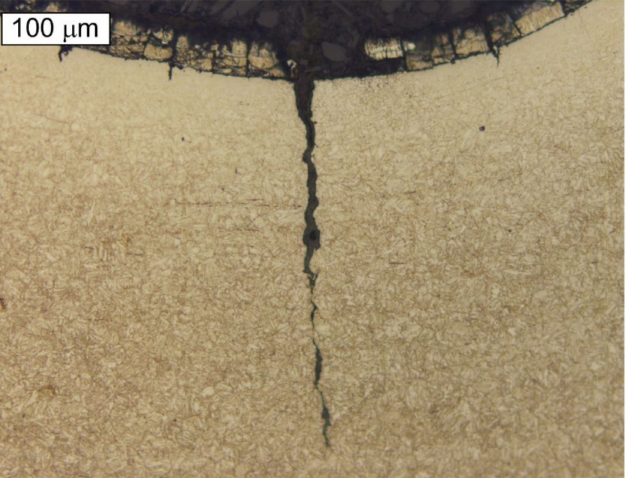
Figure 13. Martensitic microstructure of the longitudinal section of the threaded part of the S2 bolt. Visible cracks initiating in the thread root. Etched state, Light